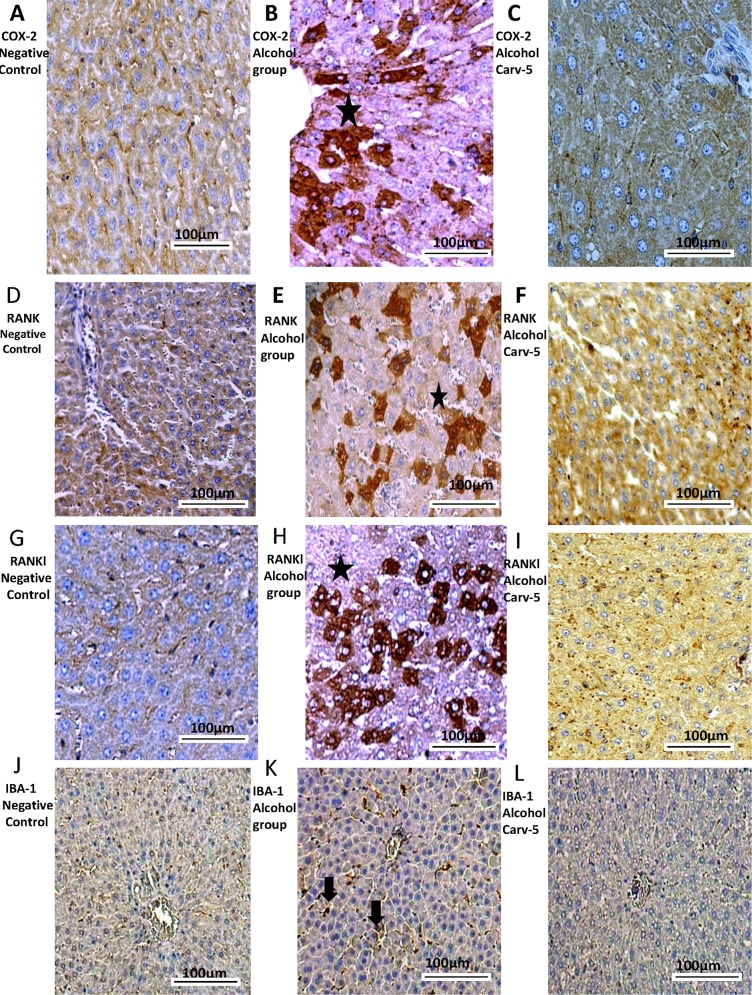
COX-2, RANK, RANK-L, and IBA-1 immunohistochemical findings.Generally, livers from alcoholic rats had greater COX-2 (B), RANK (E), RANK-L (H) and IBA-1 (K) immunoreactivity than livers from the negative control and alcohol-CARV 5 mg/kg groups. For each antigen, three immuno-labelled sections were analysed per animal (N = 5 animals per group). Asterisk: strong labelling; black narrow: labelling to Kupffer cells (IBA-1). Magnification 4000×, scale bar = 100 μm.